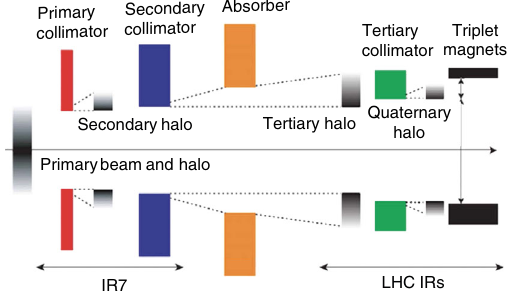
FIG. 3. LHC multistage collimation system scheme where the different collimator families are indicated [38].